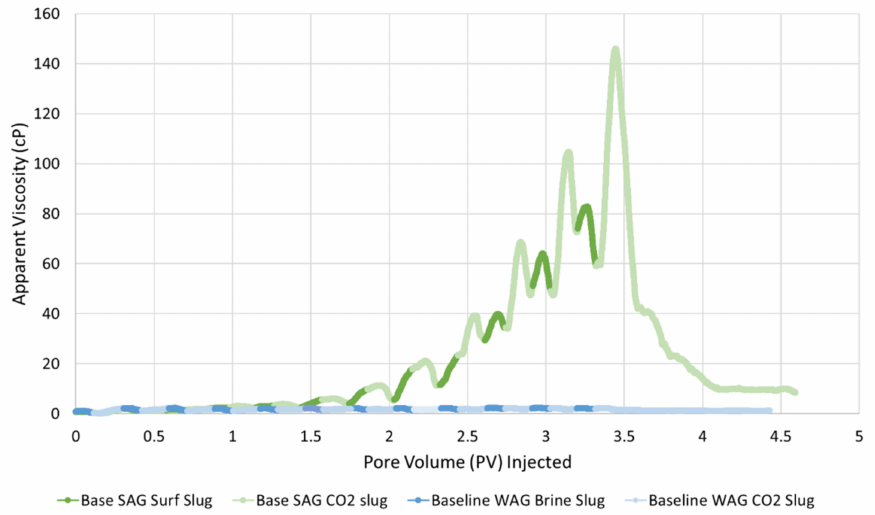
Figure 8. Apparent viscosity versus pore volume (PV) injected for 12 complete cycles for the Baseline WAG (blue curve) and the Base SAG (green curve). Surfactant solution, or water, slugs are indicated with darker colors whereas the CO 2 slugs are lighter colored.